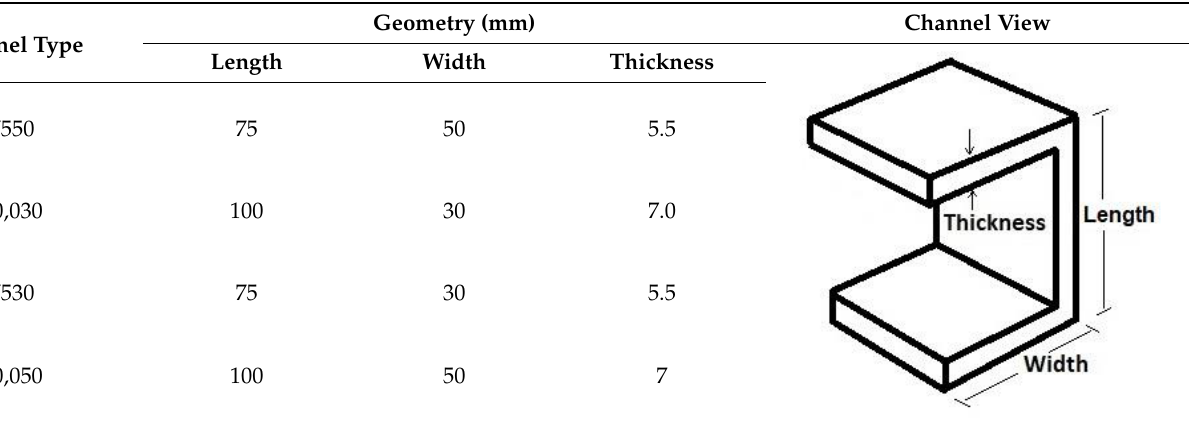
Table 1. Simulated channel geometric features.